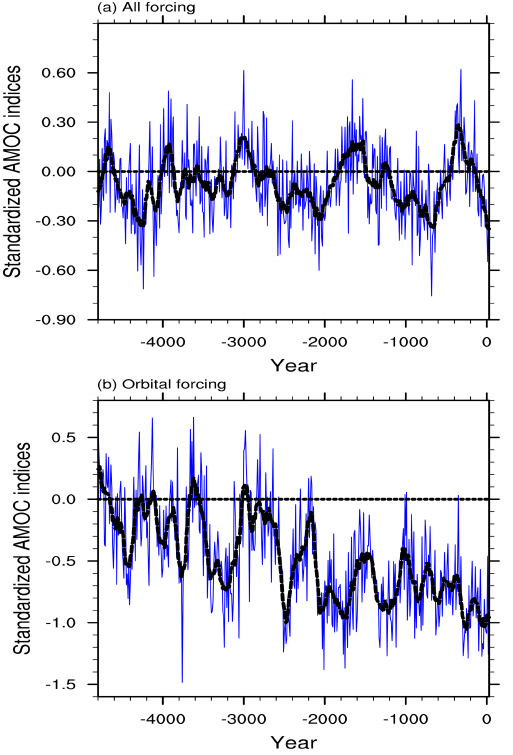
Figure 7. The 10-year running averaged (blue line) and 100-year running averaged (black line) time series of AMOC strength, plotted as anomalies from the mean for 4800–4500BP from (a) all-forcing experiment and (b) orbital-forcing experiment. AMOC strength was below the mean for 63% of the time in the all-forcing experiment and 87% of the time in the orbital-forcing experiment.